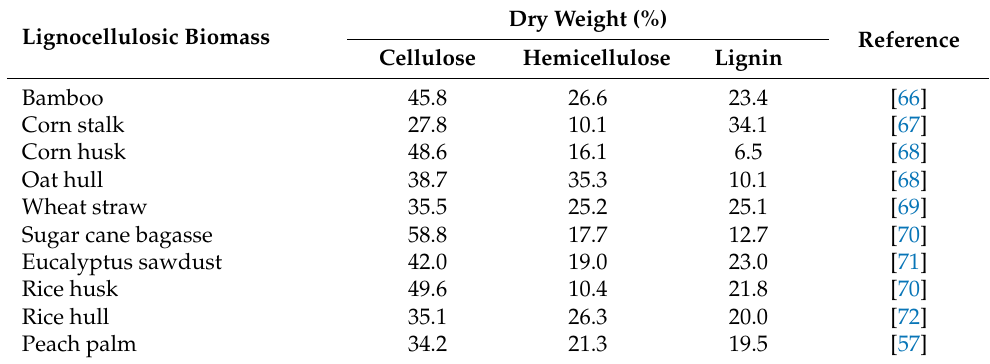
Table 4. Cellulose, hemicellulose, and lignin contents of lignocellulosic residues used in the generation of high-value-added